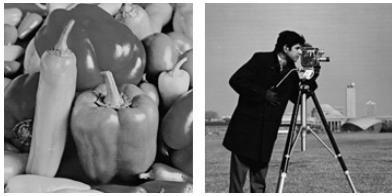
Figure 6. Two object images (“Peppe” and “Cameraman”) employed for generating testing holograms.